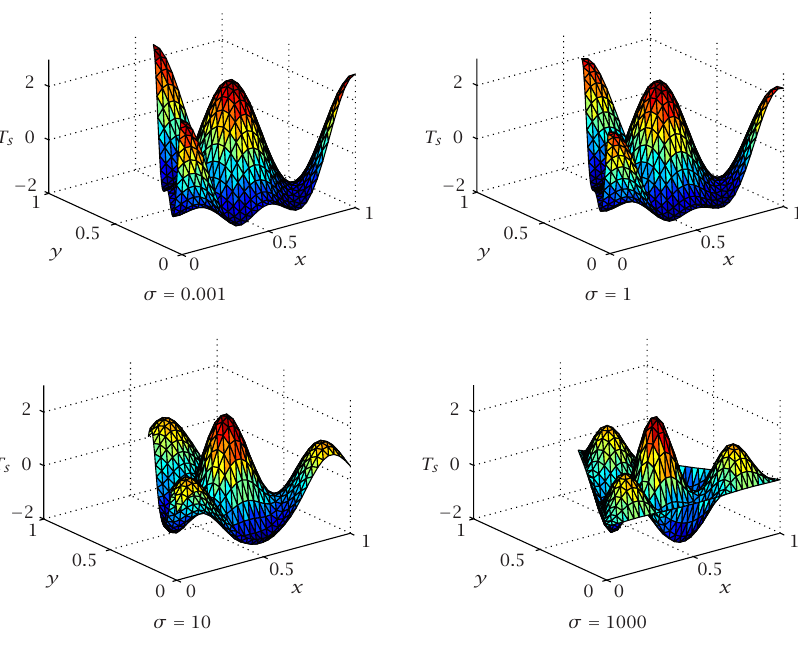
Figure 7.6 . The ( 0 , 3 ) symmetric